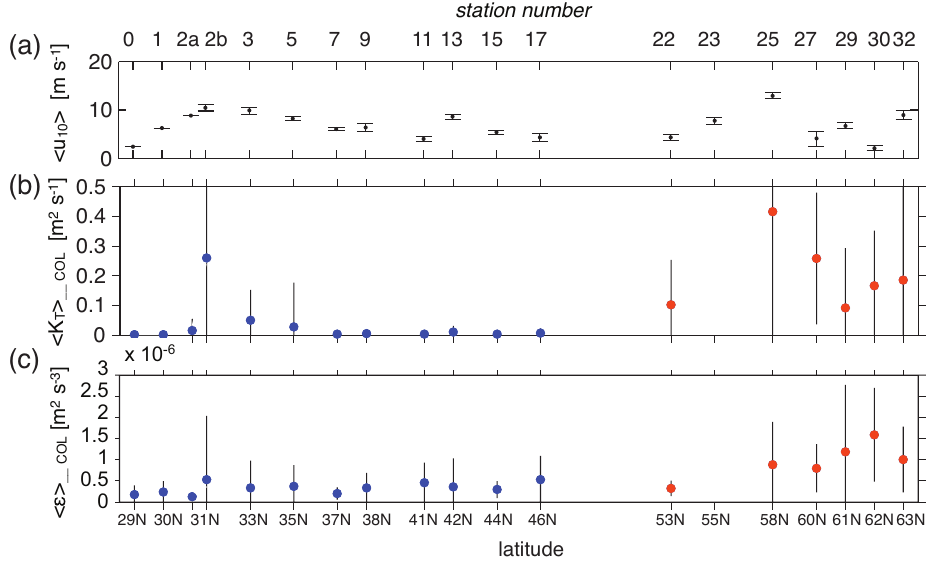
Fig. 7. Station- and column-averaged turbulence quantities, together with the station-averaged wind speeds. Graphs presented for (a) wind speed at 10m height u 10 , (b) temperature eddy diffusivity K T , and (c) TKE dissipation rate ε . The standard deviation of the station- averaged wind speeds and turbulence quantities is also depicted. The angle brackets indicate a station-average, and the notation COL indicates a column-average down to 100m depth. The stations south of 48 ◦ N are depicted in blue filled circles, and the stations north of 48 ◦ N are depicted in orange filled circles. Note that the station 23 is not shown in (b) and (c) because it had only two profiles.